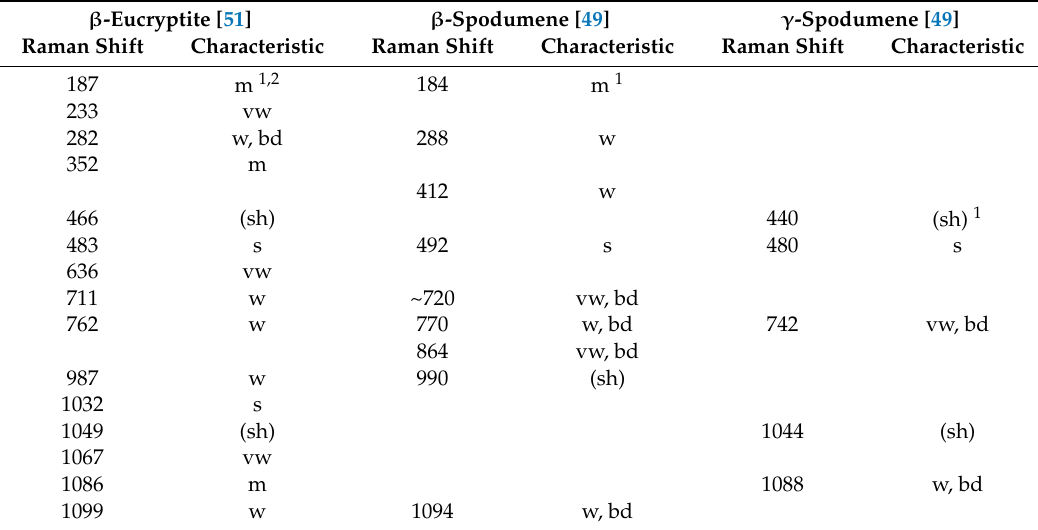
Table 6. Reported Raman shifts in cm − 1 with an accuracy of 2 cm − 1 and spectral characteristics of lithium aluminosilicates according to